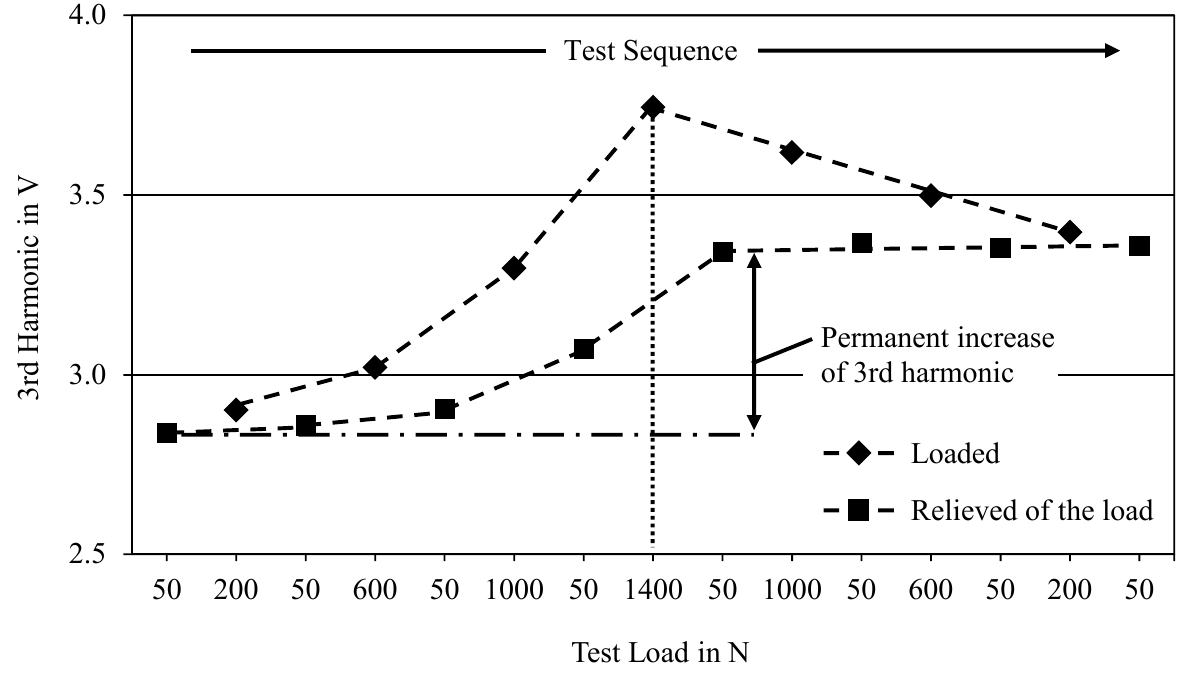
Figure 2. Amplitudes of the 3rd harmonic of Mg96Co4 measured in loading tests; eddy current ring sensor Ø 10 mm, test frequency 1.6